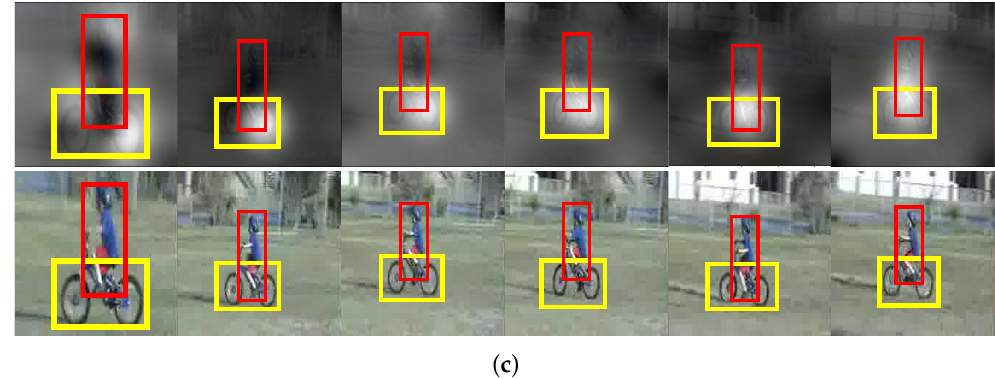
Figure 5. The illustration of difference between incorrect example and correct example. The label of ( a ) is biking, but our model recognizes it as tennis, while ( b ) is correct example of tennis and ( c ) is correct example of biking. The red case labels the location of person and the yellow one represents the location of bike in